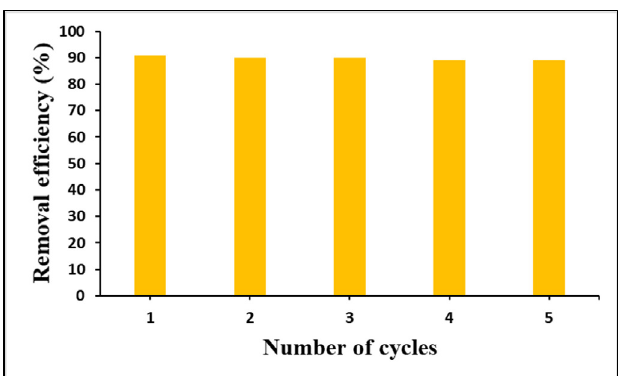
adsorbentFig. 8. The removal of Pb (II) ion by recycled